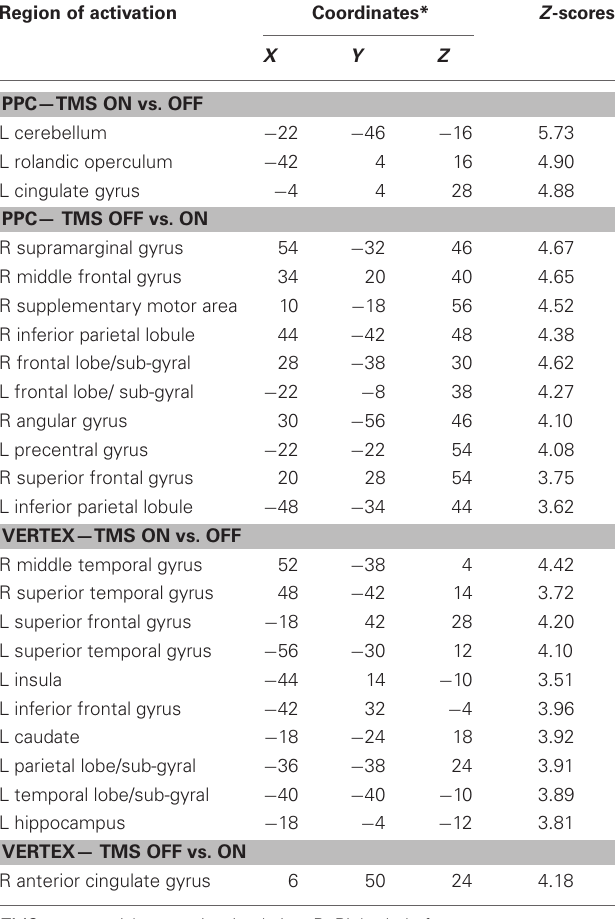
Table 3 | Group analysis: comparisons of task execution with vs. without transcranial magnetic stimulation (TMS) for parietal (PPC) stimulation and vertex